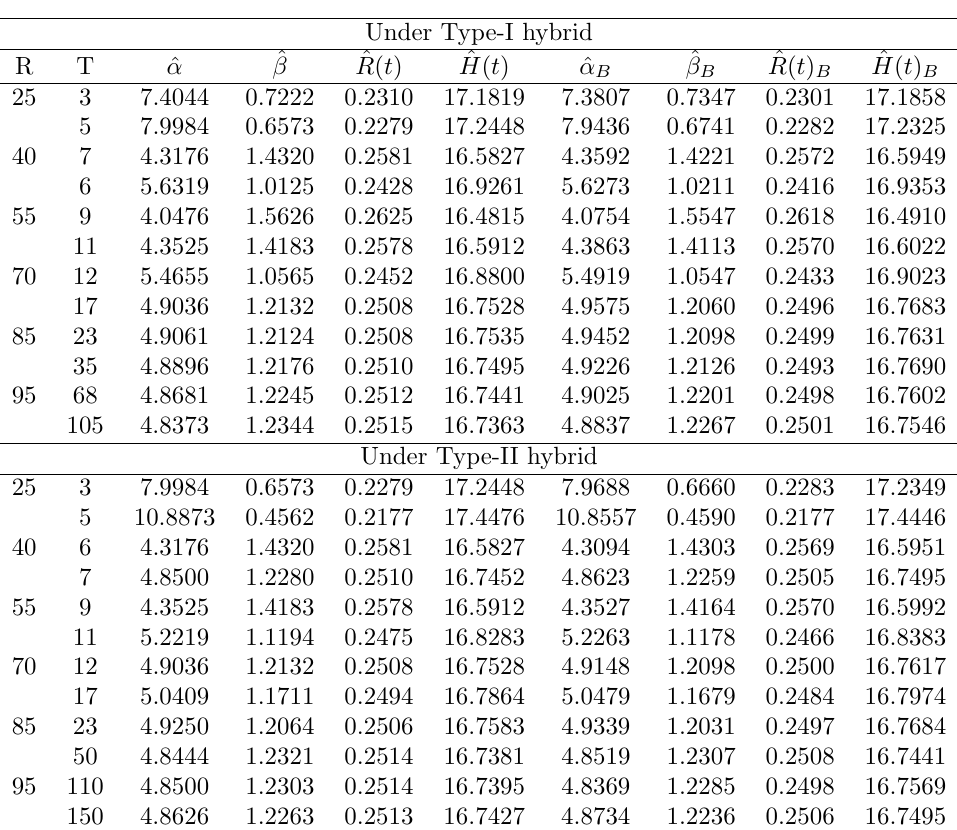
Estimates of the parameters, reliability and hazard functions for the simulated data set under different variations of the censoring